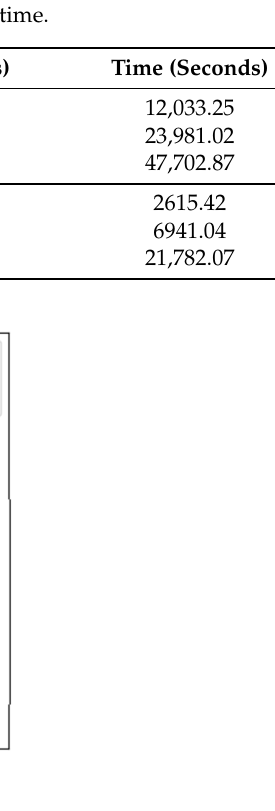
Figure 10. Per-iteration time spent on the MNIST dataset for different sizes of hidden